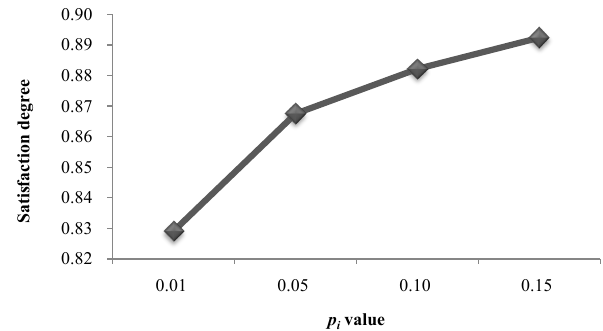
Fig. 5. Satisfaction degrees under different p i values (upper bound).